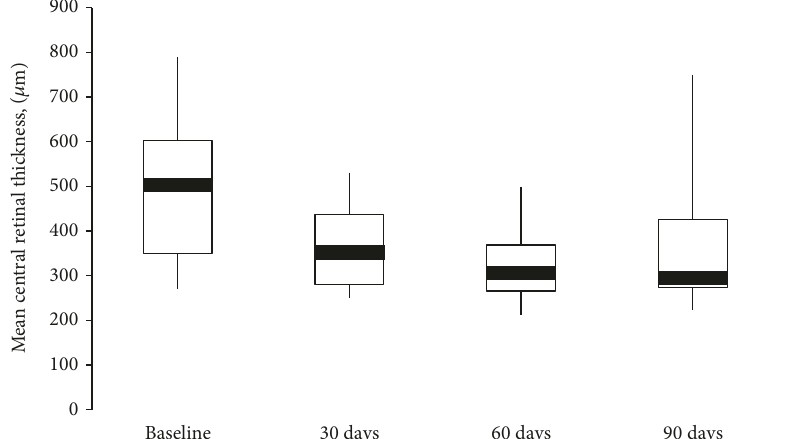
Figure 1: Boxplot of central retinal thickness (CRT) ( μ m) over 90 days. Mean CRT signi fi cantly decreased ( p ≤ 005 ), mainly at 60 days after combined